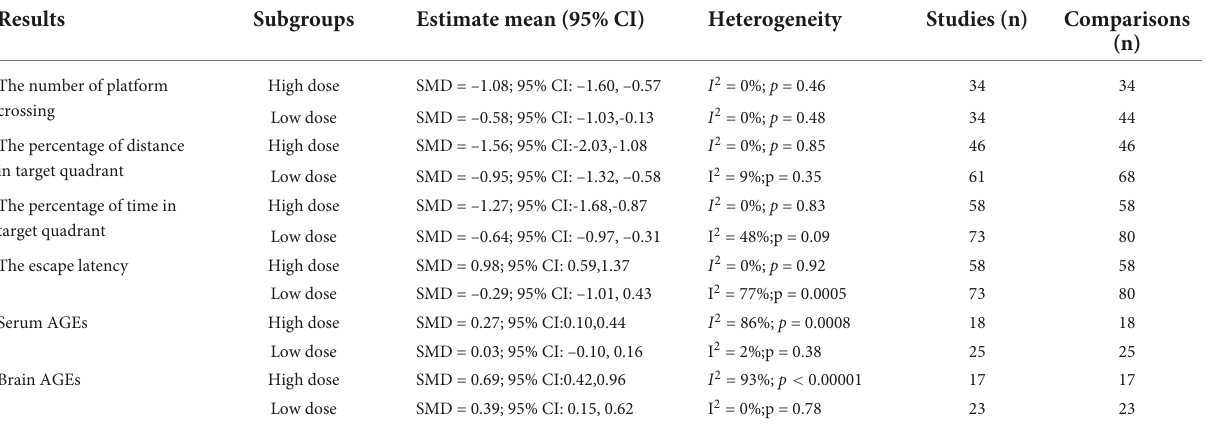
TABLE 3 Results of subgroup